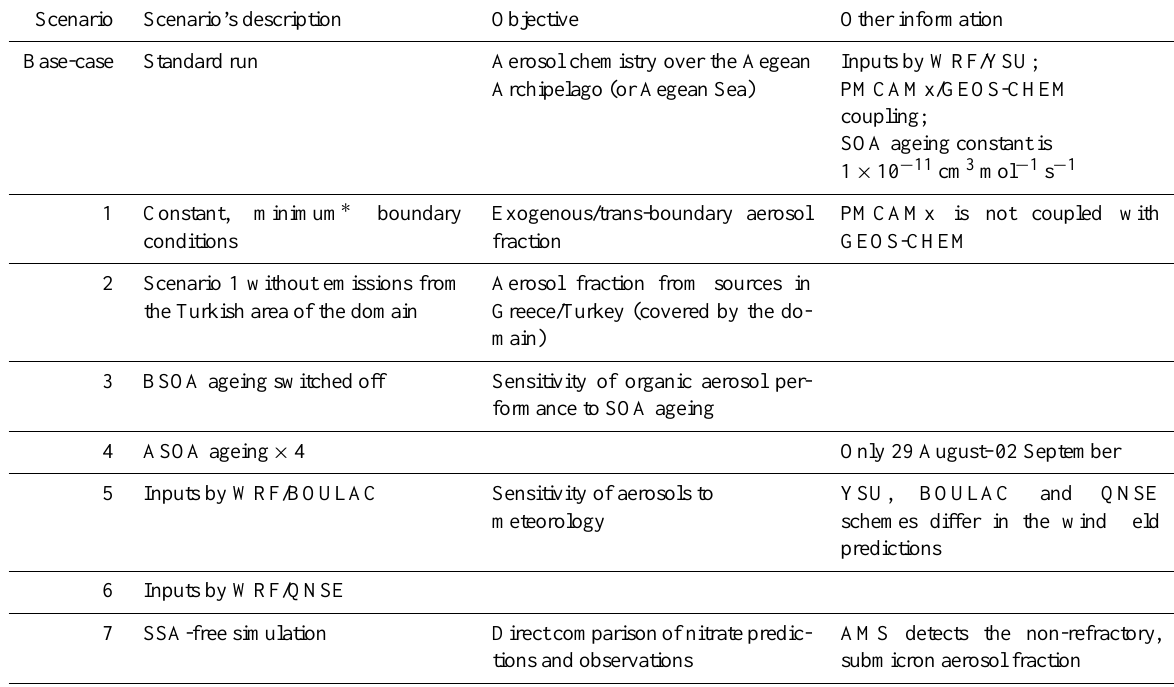
Table 3. Description of the modelling scenarios performed by the PMCAMx model during 29 August–09 September